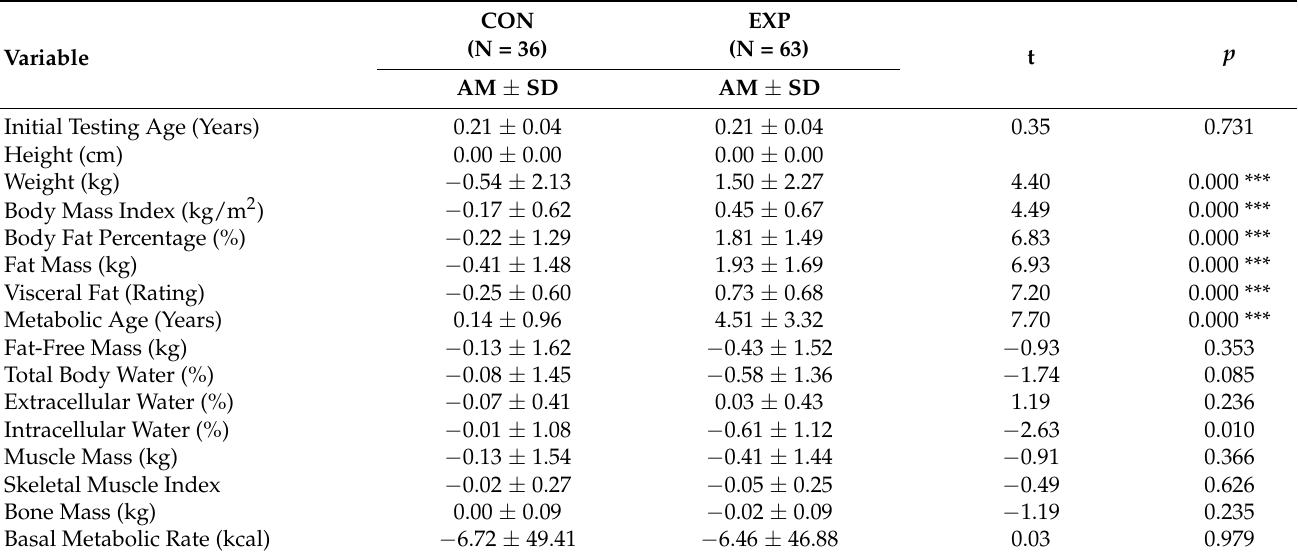
Table 5. Statistical significance of differences in arithmetic means ( t -test) of chronological age and anthropometric characteristics in the changes in values of the measured variables between the initial and final measurements in the control and experimental